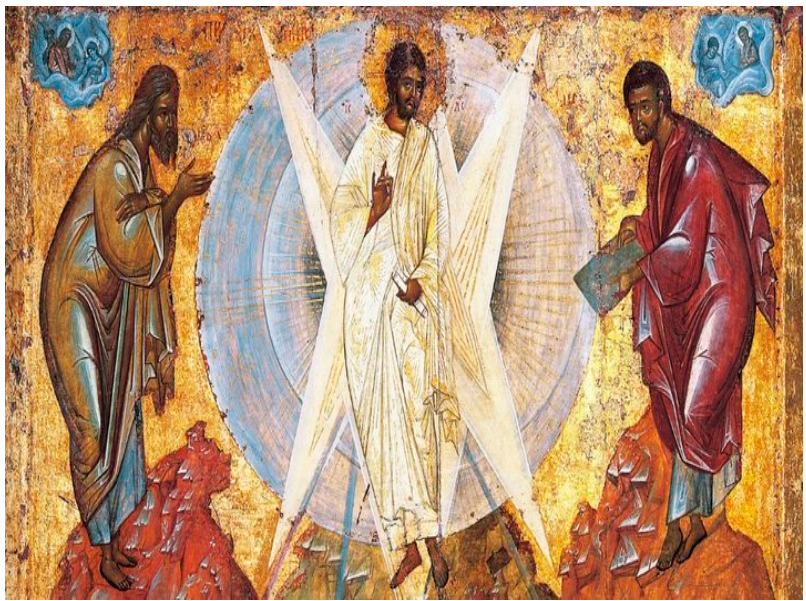
Figure 11. The Orthodox icon representing Christ as a manifestation of the emanating divine Light of Tabor.